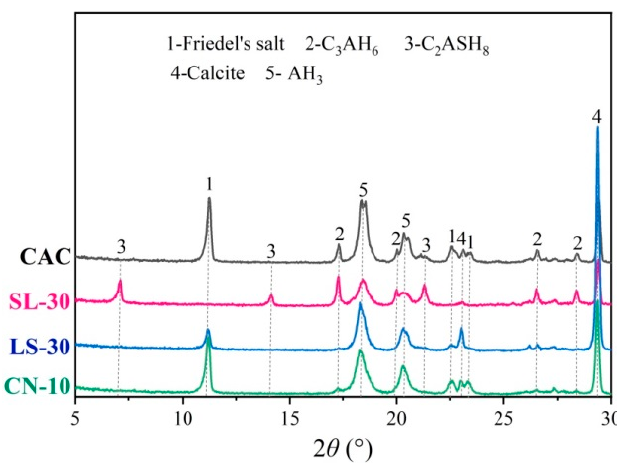
Figure 7. XRD pattern of modified CAC pastes immersed in 100 g/L NaCl solution for 90 days.